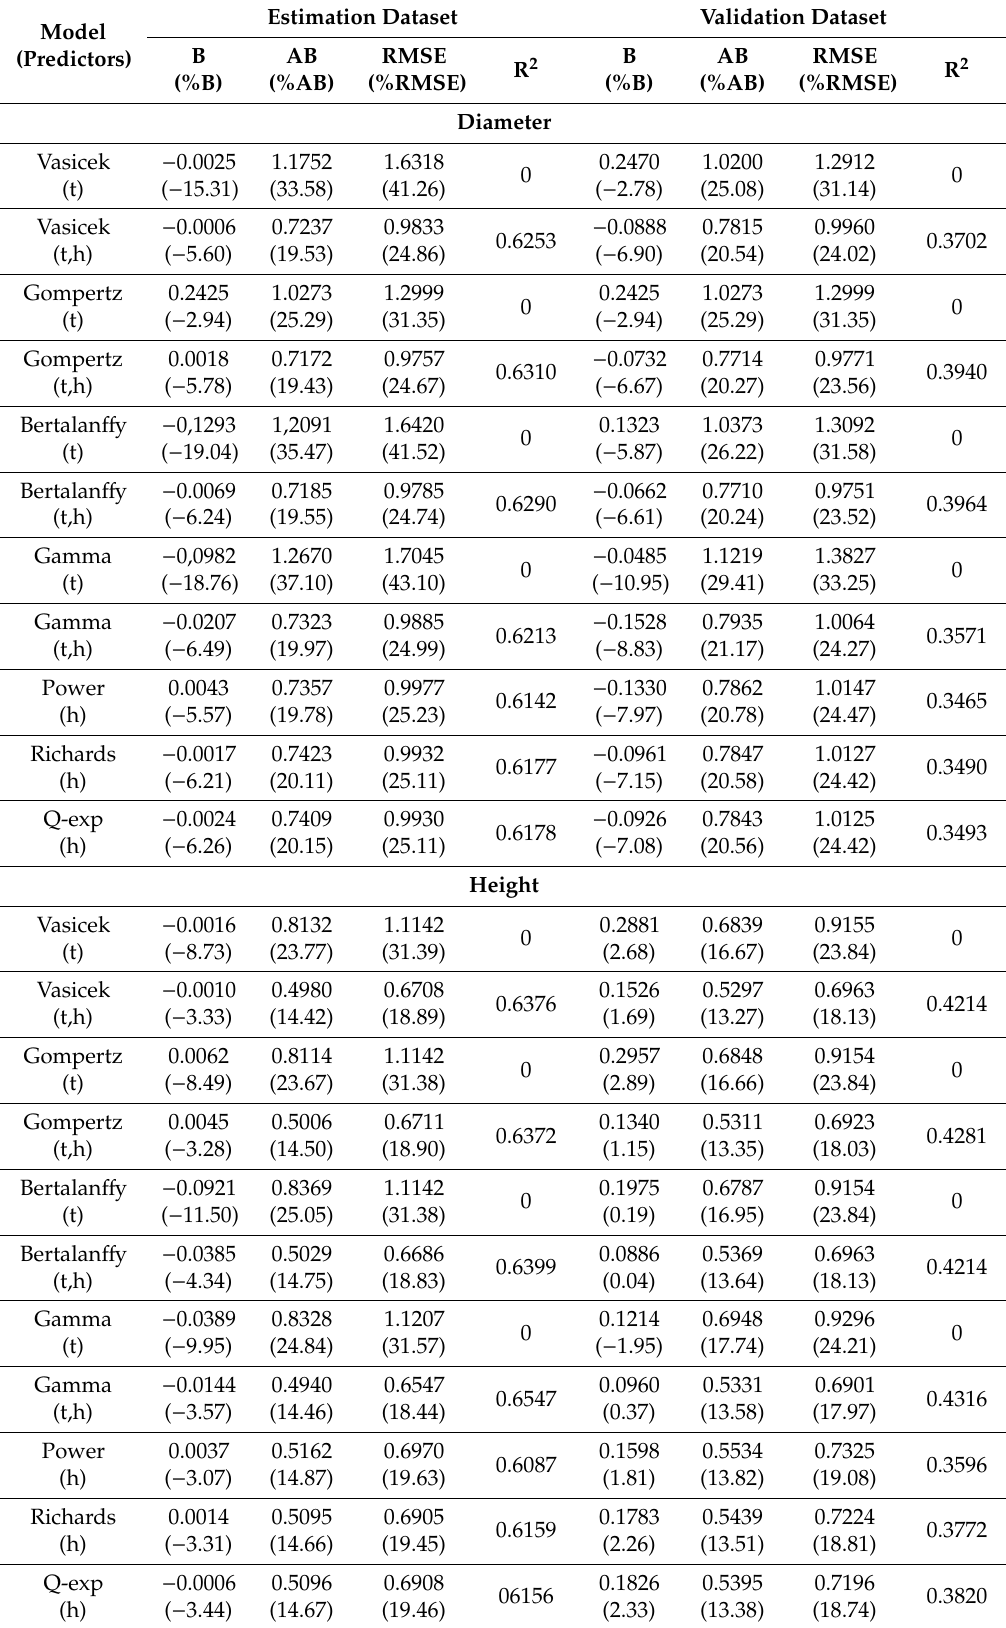
Table 9. Statistical measures for all fitted fixed-e ff ect parameter diameter, D, and height, H,